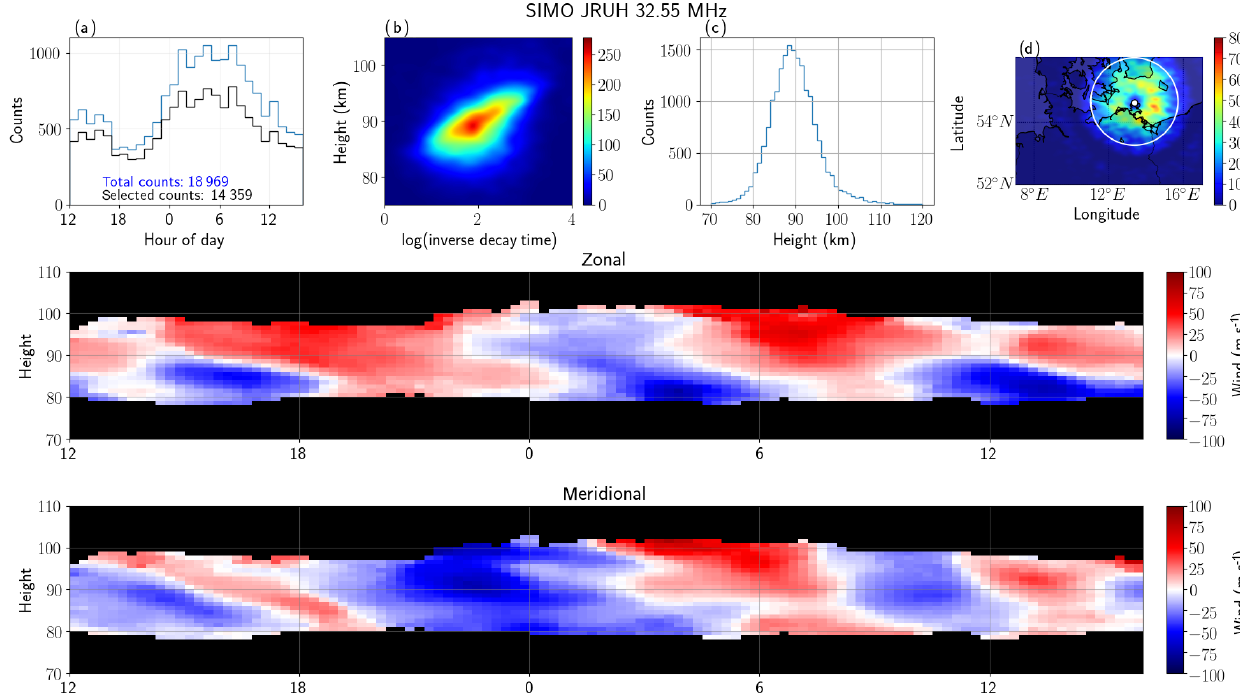
Figure 2. MLT observations with a monostatic SMR system at Juliusruh on 11 July 2018. The first row shows a (a) time histogram, (b) 2-D histogram of altitude vs. inverse decay time (log scale) color-coded in linear scale, (c) altitude histogram, (d) 2-D histogram of latitude vs. longitude (linear scale). The zonal and meridional winds in bins of 1h and 2km are presented in the second and third rows, respectively. Note that the region of fewer counts in (d) is over the radar